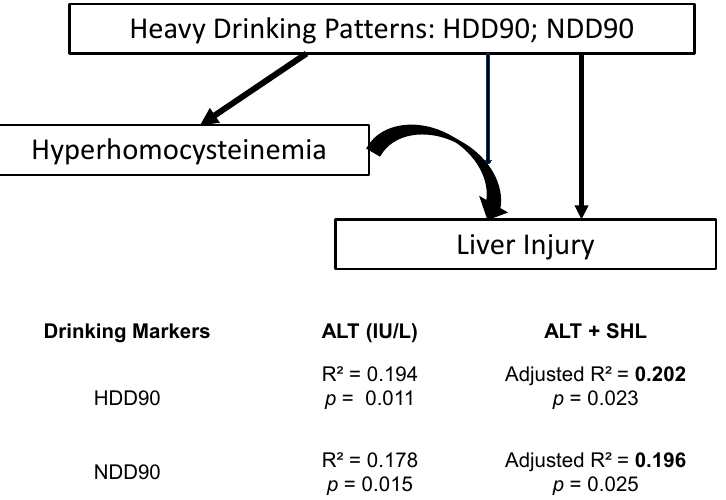
Figure 4. Association of ALT and markers of heavy drinking in the elevated homocysteine group of AUD patients (Gr. 2). ( a ) Significant association of ALT and total drinks past 90 days (TD90). ( b ) Significant association of ALT and NDD90. ( c ) Significant association of ALT and HDD90. Statistical significance was set at p ≤ 0.05. R 2 denotes the effect of the relationship as an outcome of univariate linear regression.